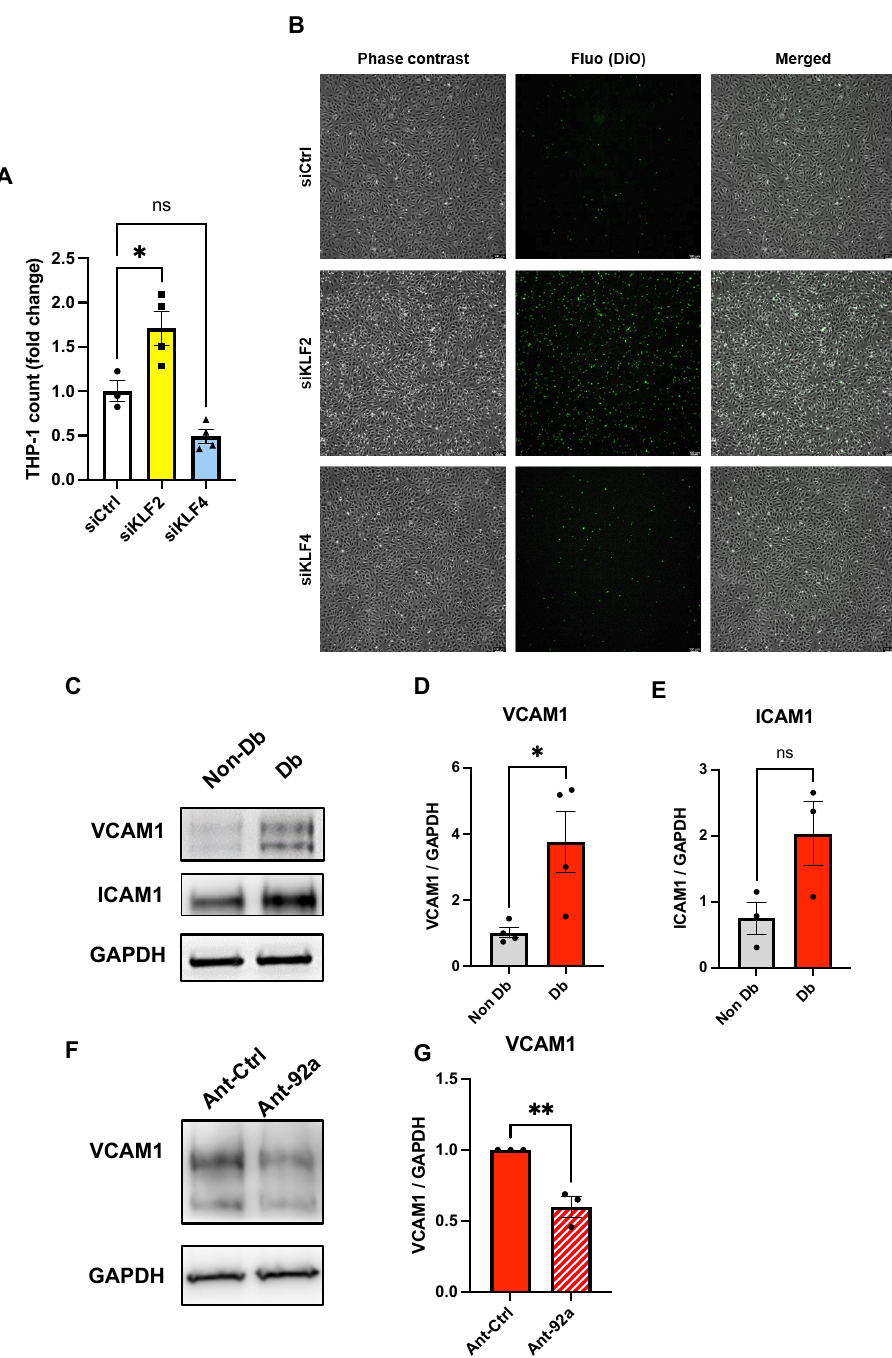
Figure 2. Endothelial inflammatory phenotype driven by KLF2 ablation. ( A ) Analysis of fold change in adherent THP-1 count in nondiabetic HCMEC monolayers upon knockdown of KLF2 (siKLF2) or KLF4 (siKLF4) relative to controls (siCtrl) ( n = 4). ( B ) Representative phase contrast, fluorescence, and merged images of HCMEC monolayers and DiO-labeled THP-1 (green). Scale bars equal 100 µ m. ( C ) Western blot and analysis of relative protein expression of VCAM1 ( D ) and ICAM1 ( E ) in diabetic HCMECs relative to nondiabetic controls (GAPDH is considered a housekeeping protein) ( n = 4). ( F , G ) Western blot analysis of relative expression and representative blot of VCAM1 in protein lysates from diabetic HCMECs upon miR-92a inhibition by antagomir (Ant-92a) relative to controls (Ant-Ctrl) normalized to GAPDH as a housekeeping protein. Statistical analyses by unpaired Student’s t -test or by one-way ANOVA ( n ≥ 3); * p < 0.05; ** p <